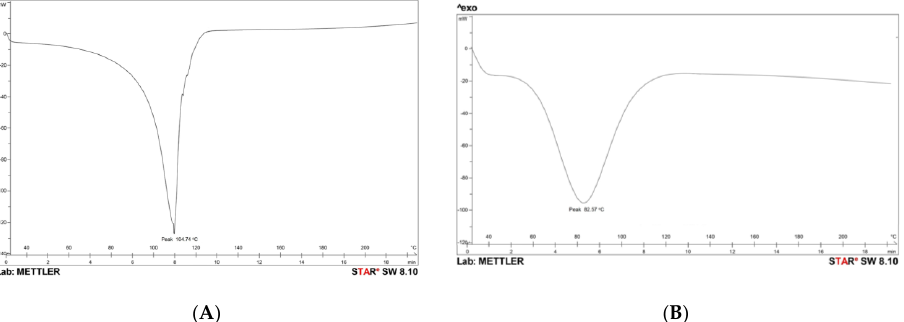
Figure 6. Differential scanning colorimetry of pure-drug and methotrexate-loaded formulations: ( A ) Pure drug; ( B ) Methotrexate-loaded formulation.